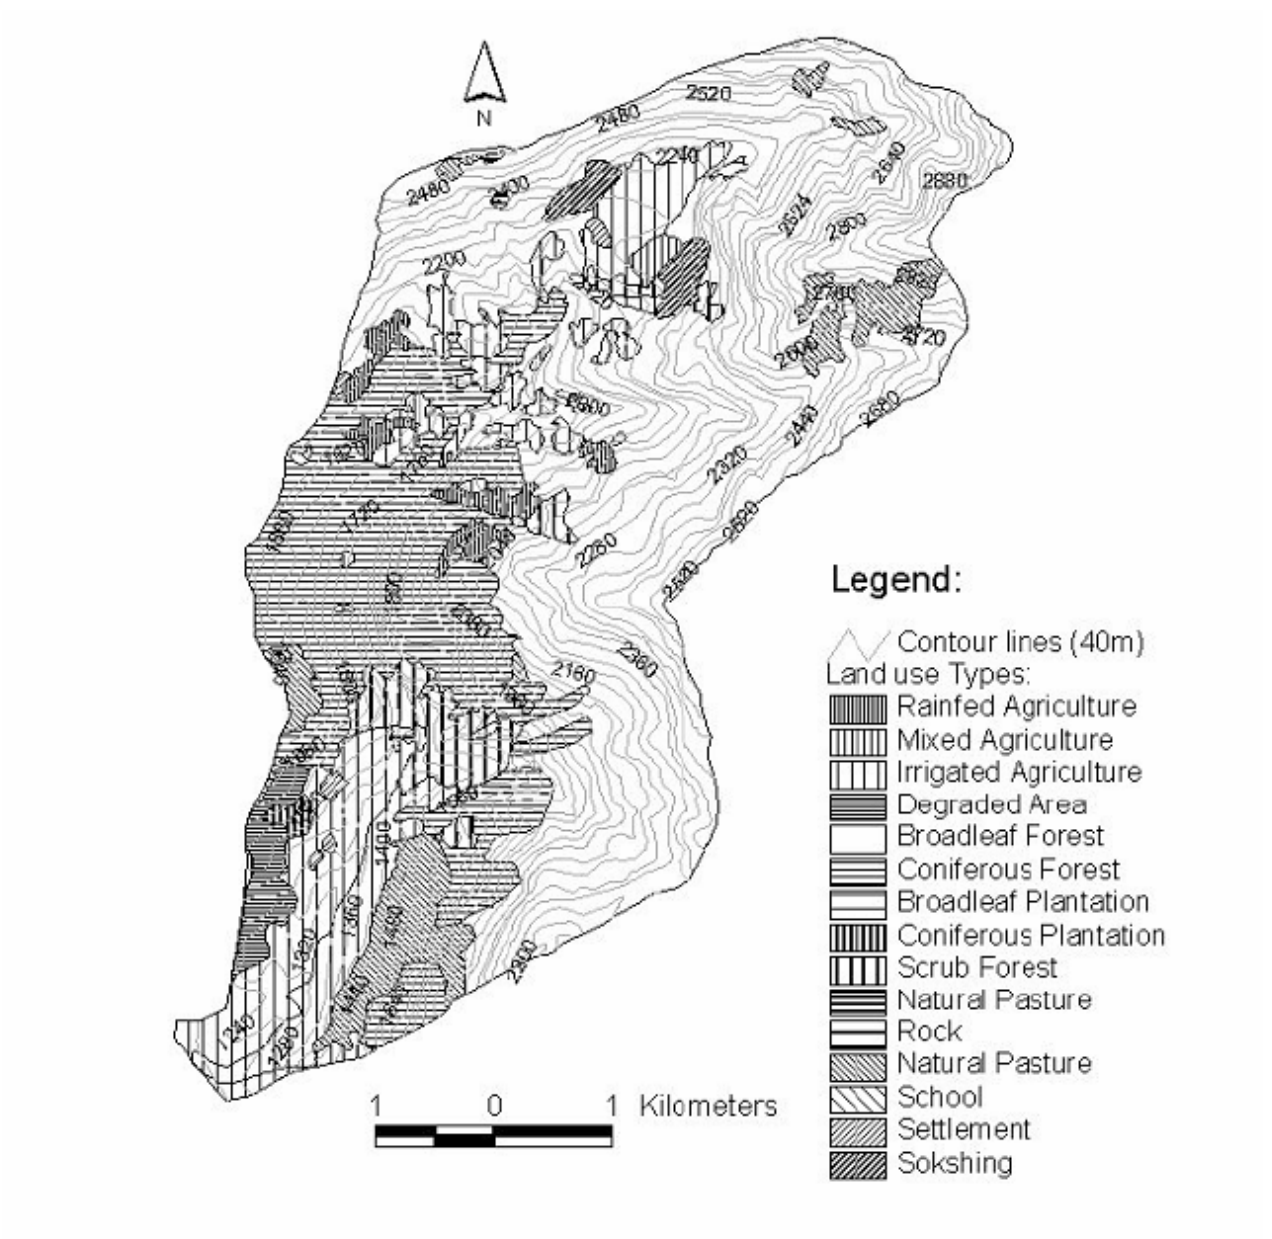
Fig. 2. Map of the study area: Lingmuteychu watershed, Punakha District, West-central